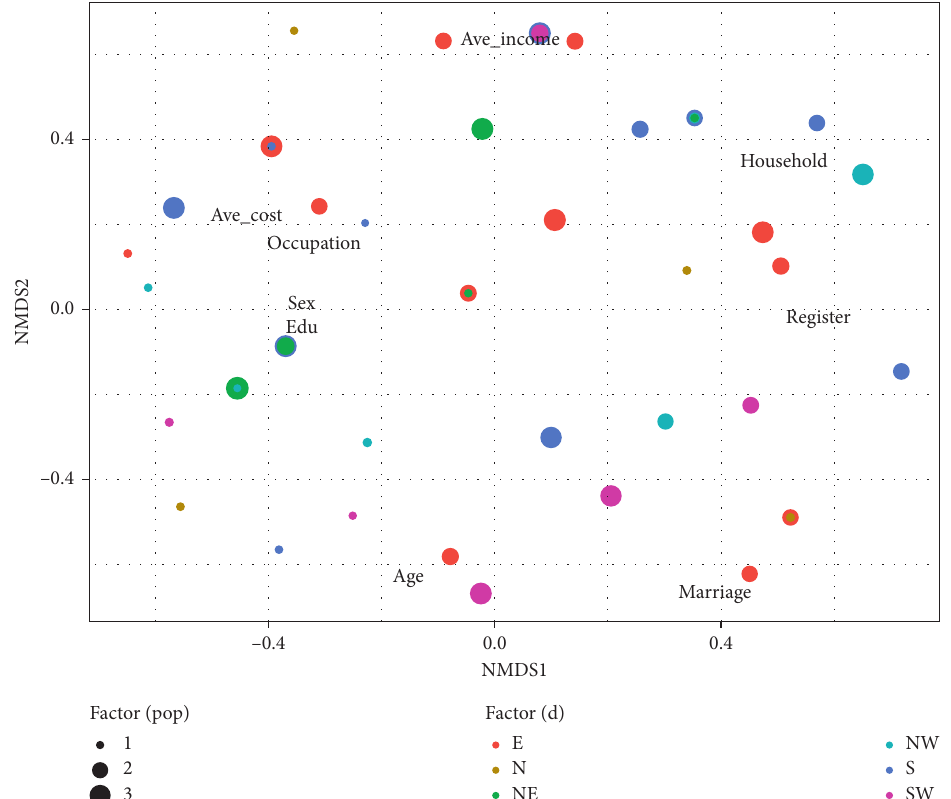
Figure 10: Nonmetric multidimensional scaling (NMDS) analysis of top significant factors. Note. (1) Pop represents the population of the city; the larger the circle, the larger the population. (2) Factor d represents the six regions. (3) Its coordinate axis is only set to reflect the distance relationship between samples after